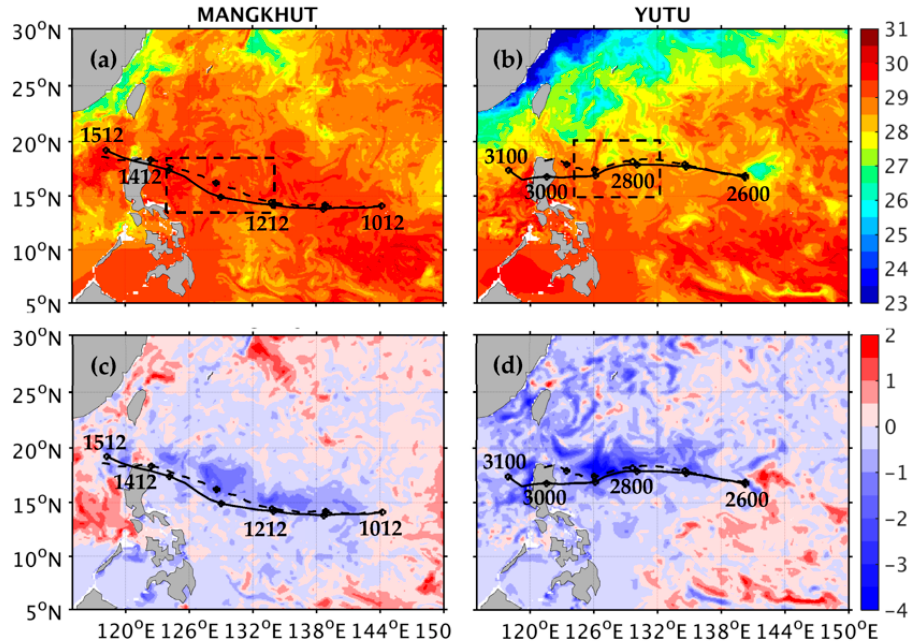
Figure 3. Initial sea surface temperature for ( a ) MK-CTL at 1200 UTC 10 September 2018 and ( b ) YT-CTL at 0000 UTC 26 October 2018. SST difference (shaded colors in °C) between 96 h and the initial time for ( c ) MK-CTL and ( d ) YT-CTL. The dashed and solid lines show the simulated tracks of the CTL and the best track from the JTWC, respectively. Solid circles in the tracks indicate the typhoon centers at an interval of 24 h. The dashed box indicates the oceanic region where the associated temperature changed in the ocean–temperature sensitivity experiments.